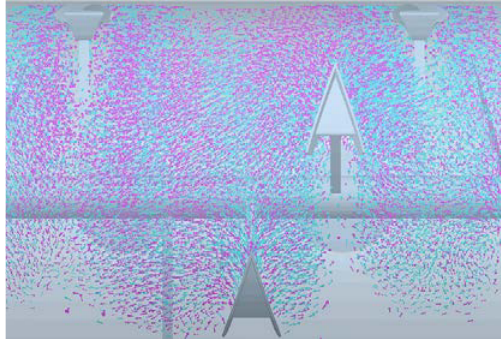
Fig. 7. Effect of ploughshares on particles.